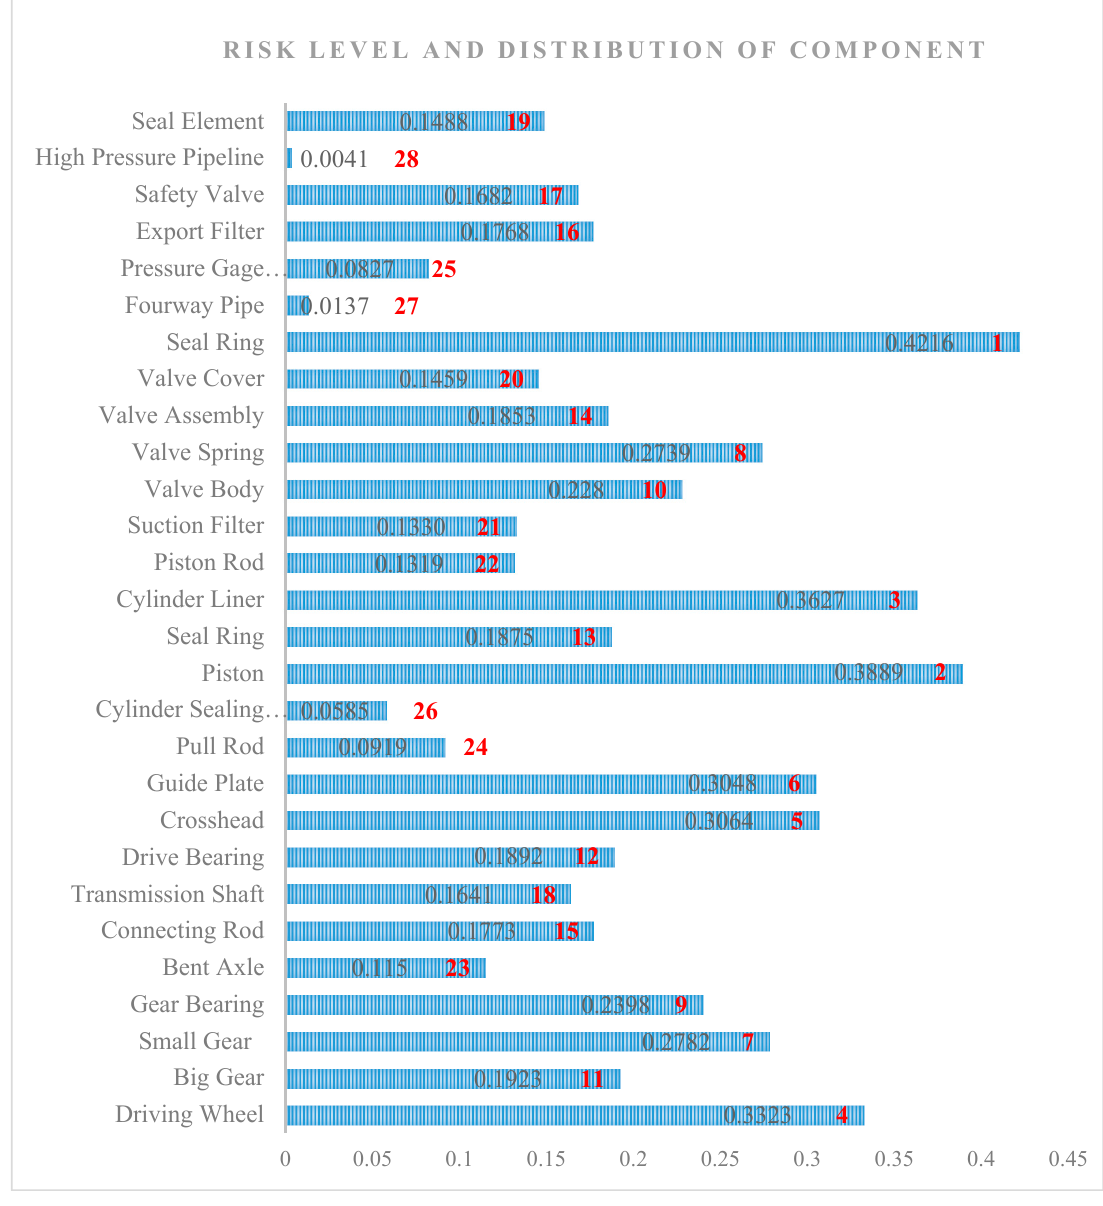
Figure 7. Risk ranking, shown by the red numbers, and risk distribution of components in the reciprocating pump system (RPS).